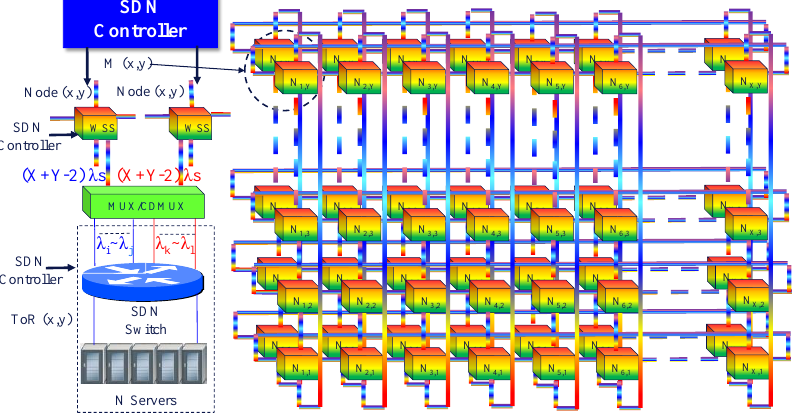
Figure 2. Multi-plane Torus topology optical tunnel switching network.